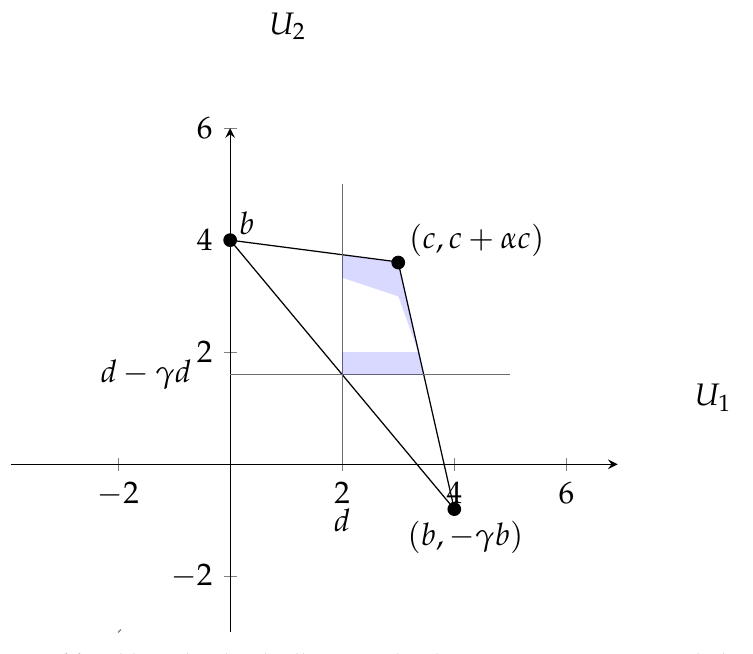
Figure 2. The set of feasible and individually rational utility vectors. One emotional player with three states of mind and one Homo oeconomicus play the